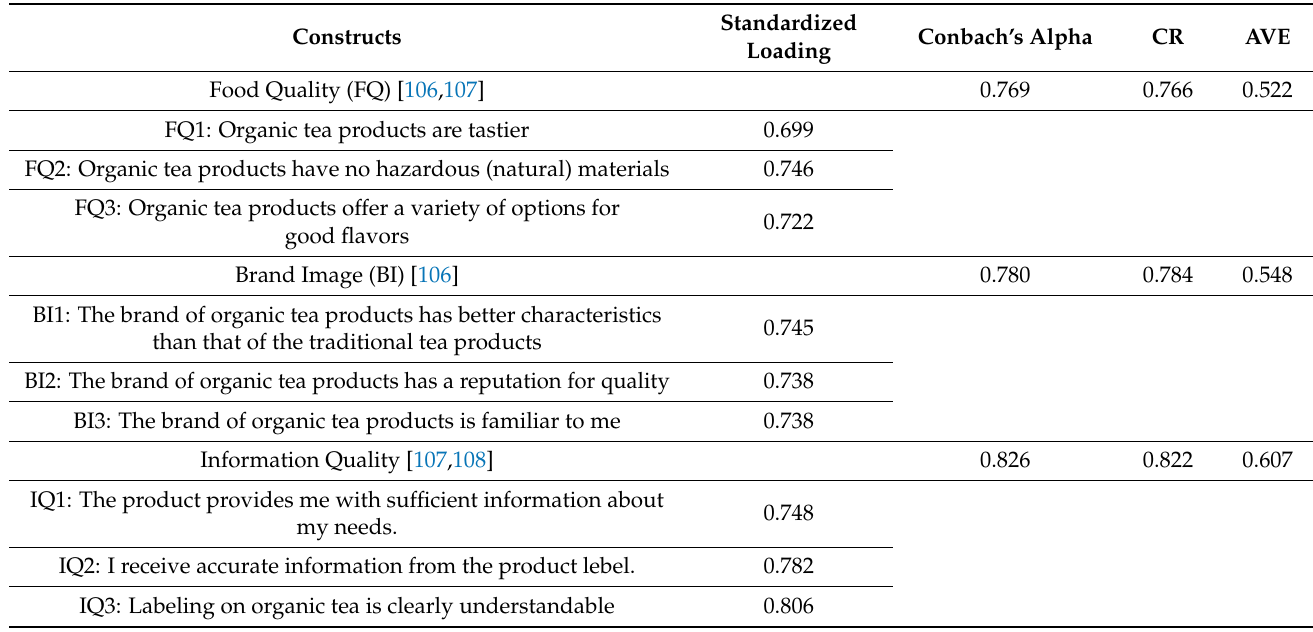
Table 2. Reliability and validity